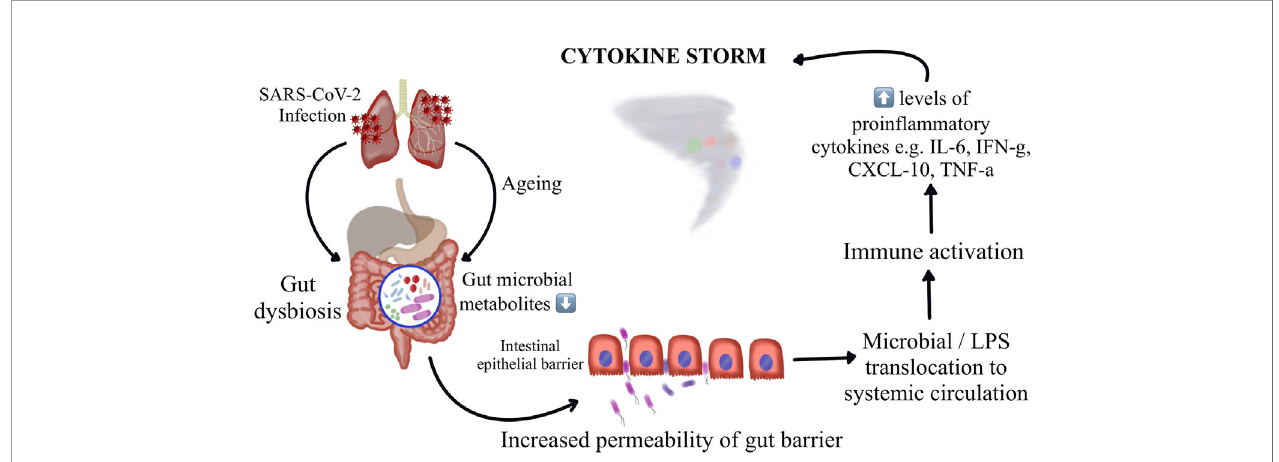
FIGURE 1 | Schematic representation of the proposed hypothesis of gut microbiota perturbation leading to severe COVID-19 by cytokine